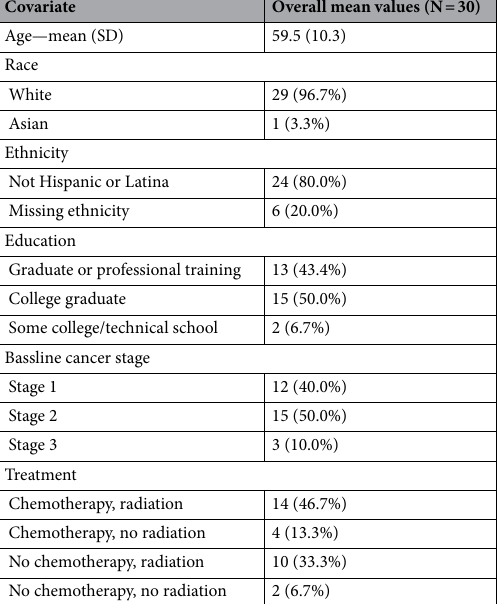
Table 1. Demographic summary of the study